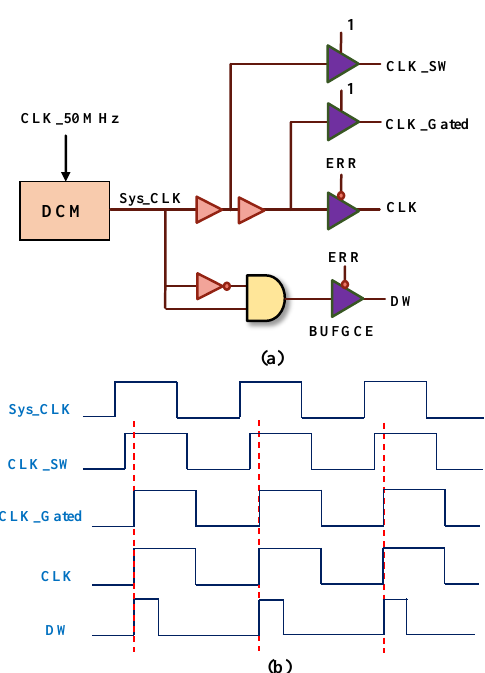
Figure 3. ( a ) Clock generator circuit and ( b ) its timing